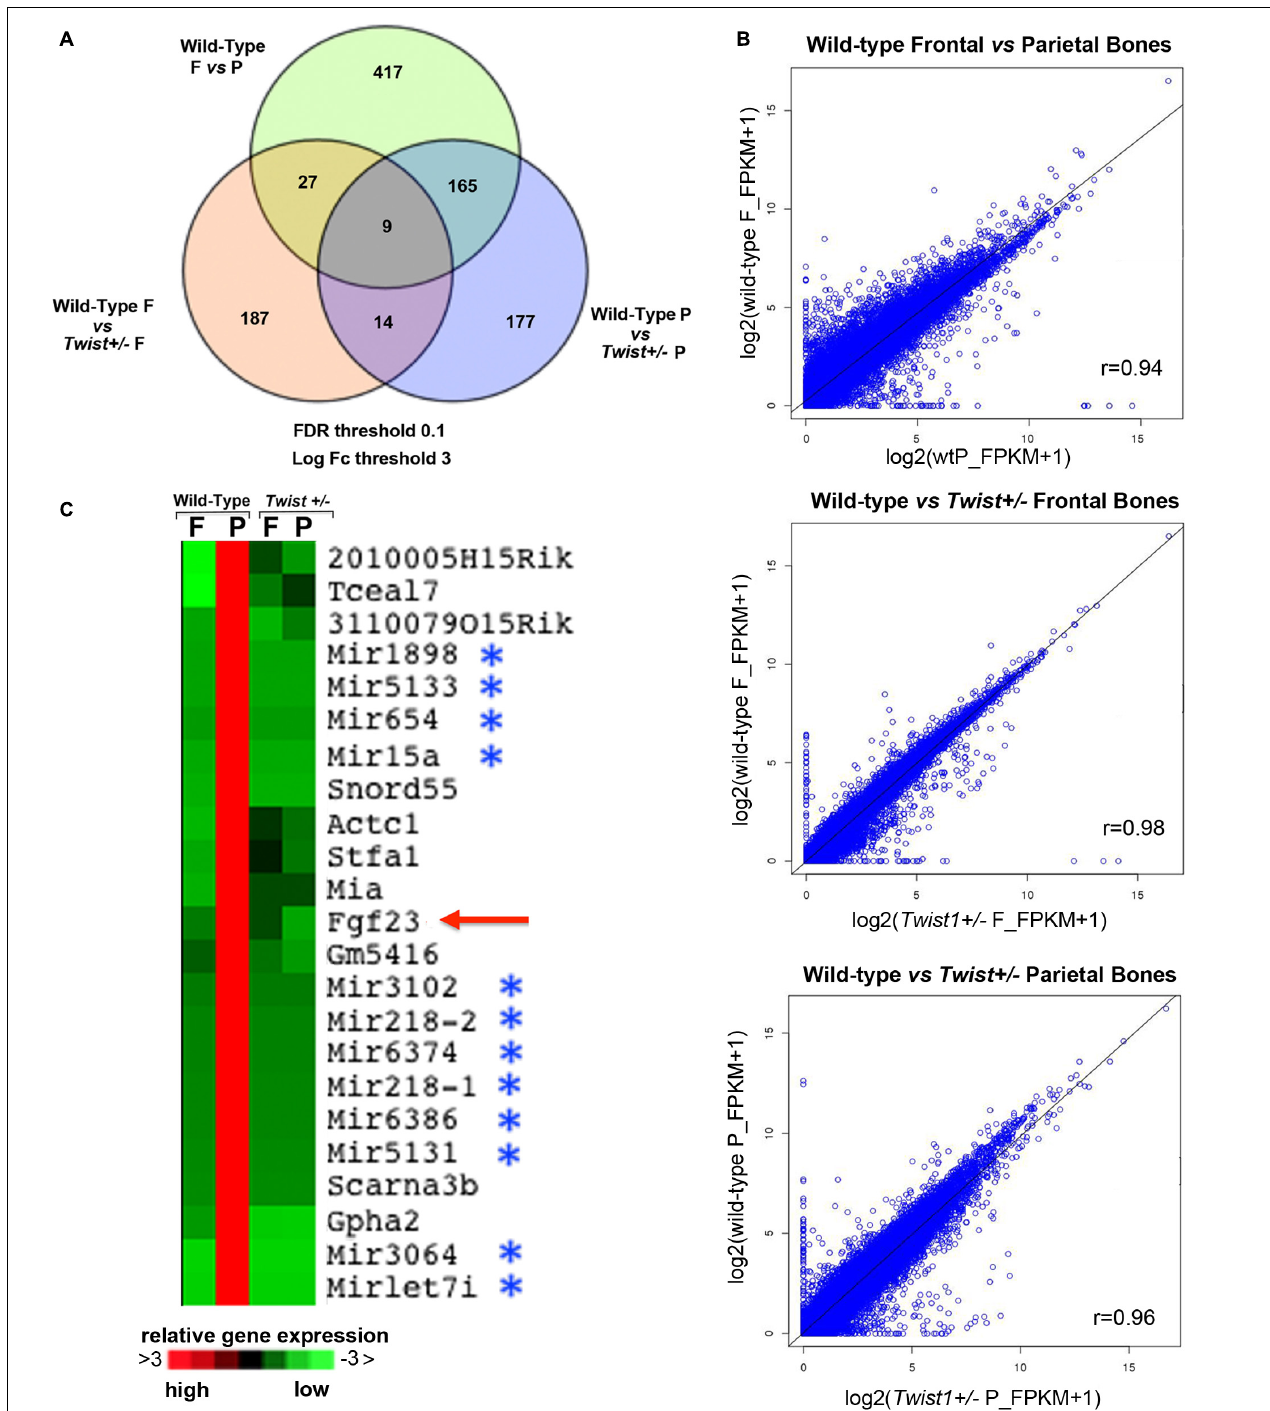
FIGURE 3 | Transcriptomic profiles of wild-type and Twist + / − frontal and parietal bones. RNA-Seq analysis to assess gene expression changes caused by Twist1 haploinsufficiency in calvarial bone of pN21 mice revealed significant differences. (A) Venn diagram showing the comparison of top genes found differentially expressed (up and down regulated) in wild-type and Twist + / − Frontal (F) and Parietal (P) bones for FDR < 0.1 and log 2 (fold change) > 3, with fold change as ratios of gene-level FPKM values. Their gene expression levels are affected ≥ 3 fold. (B) Scatterplot representation showing the fold change Scatter plots of gene expression of genes [based on log 2 (FPKM + 1) expression values with each dot representing a gene]. In the bottom of each graph the pair-wise Pearson’s correlation (r) for all genes is shown. (C) Heatmap showing Fgf23 as a component of a unique signature of genes that are exclusively upregulated in wild-type parietal bones. (upregulation in Red; downregulation in